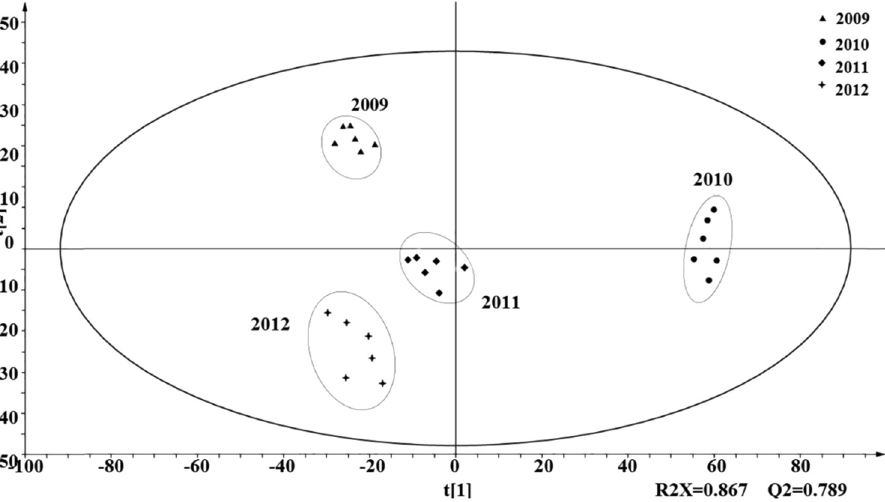
Figure 2: PCA score plot of Cabernet Sauvignon wines of di ff erent